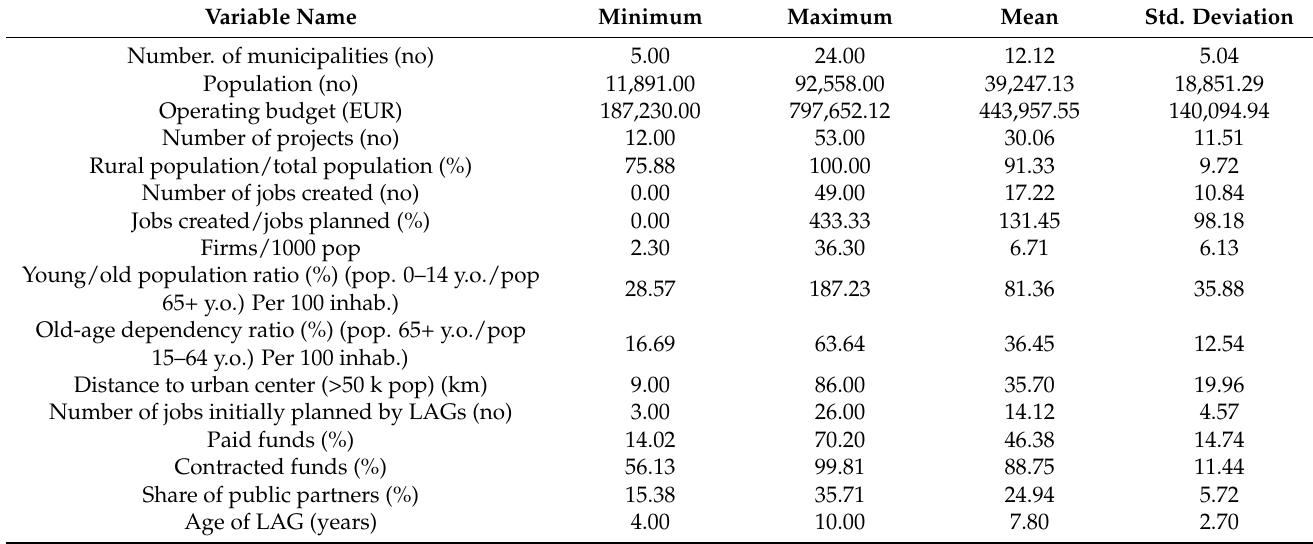
Table 1. Descriptive statistics of the selected